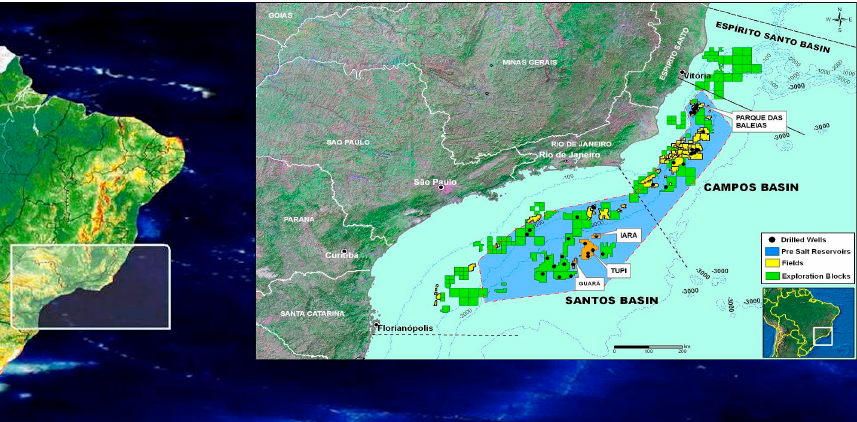
Figure 4. The Santos and Campos Basins with the location of the Lula Field. From Reference [19].